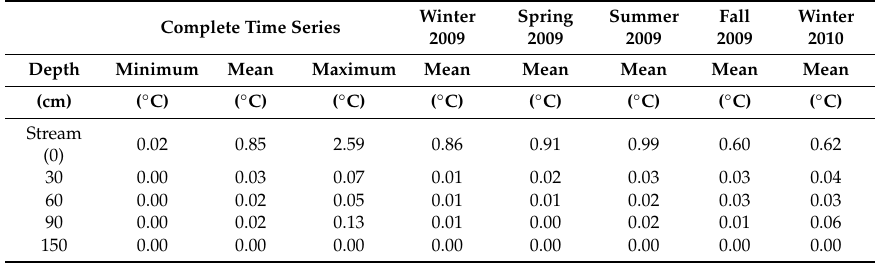
Figure 4. Week-long temperature time series with storm events at 30, 60, 90, 150 cm depth. There are storm events on 8 / 17, 8 / 18, 8 / 20, and 11 / 17–11 / 19. The summer temperature gradient is negative ( a ), and the winter is positive ( b ). The stream temperature signal change during the storm event propagates down to a streambed depth of 90 cm in the winter and summer. Table 2. Seasonal amplitude averages at each temperature sensor